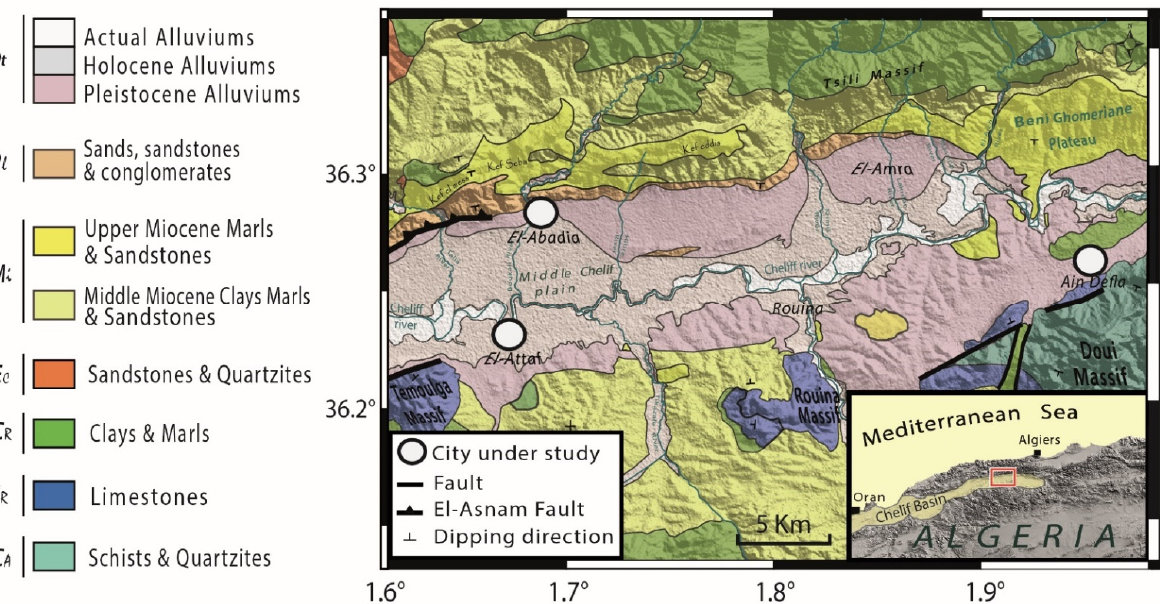
Figure 2. Geological map of the study area. Compiled and modified from [22,24].